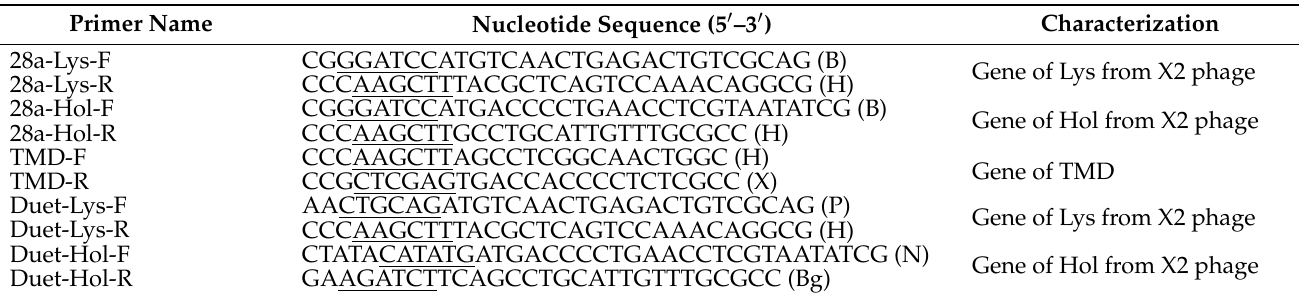
Table 2. Primers used in this